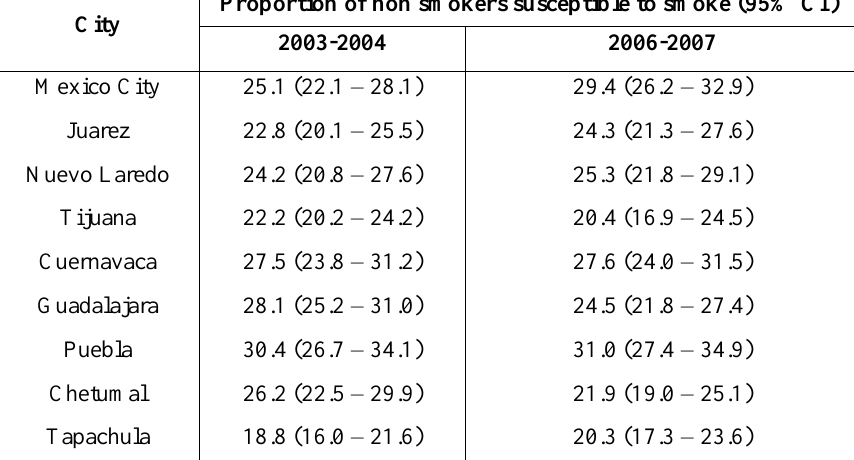
Table 4. Susceptibility to smoking among never smokers. GYTS Mexico 2003-2004 and